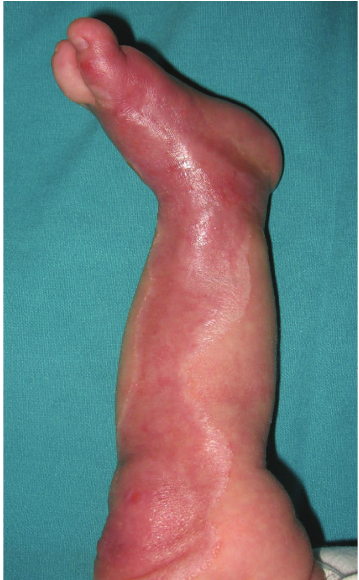
Figure 1: Large skin defects on left extremity at birth.